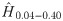
ROC curves.for H^0.04−0.40 superimposed to that obtained from LF/HF0.15 are found to yield equivalent performance while the former avoids the recourse to the arbitrary and irrelevant choice of the intermediate frequency f
interm = 0.15Hz.